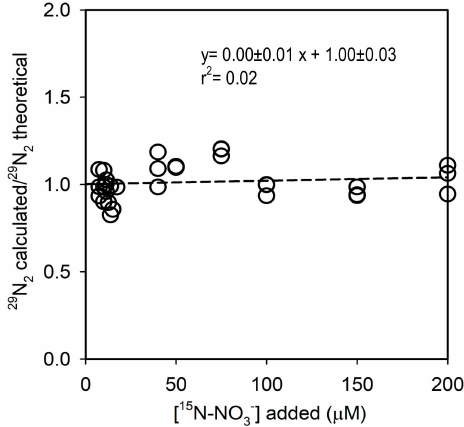
Figure 6. Ratios of calculated versus predicted 29 N 2 along a concentration series of 15 N-NO 3 − , targeting the co-occurrence of anammox and